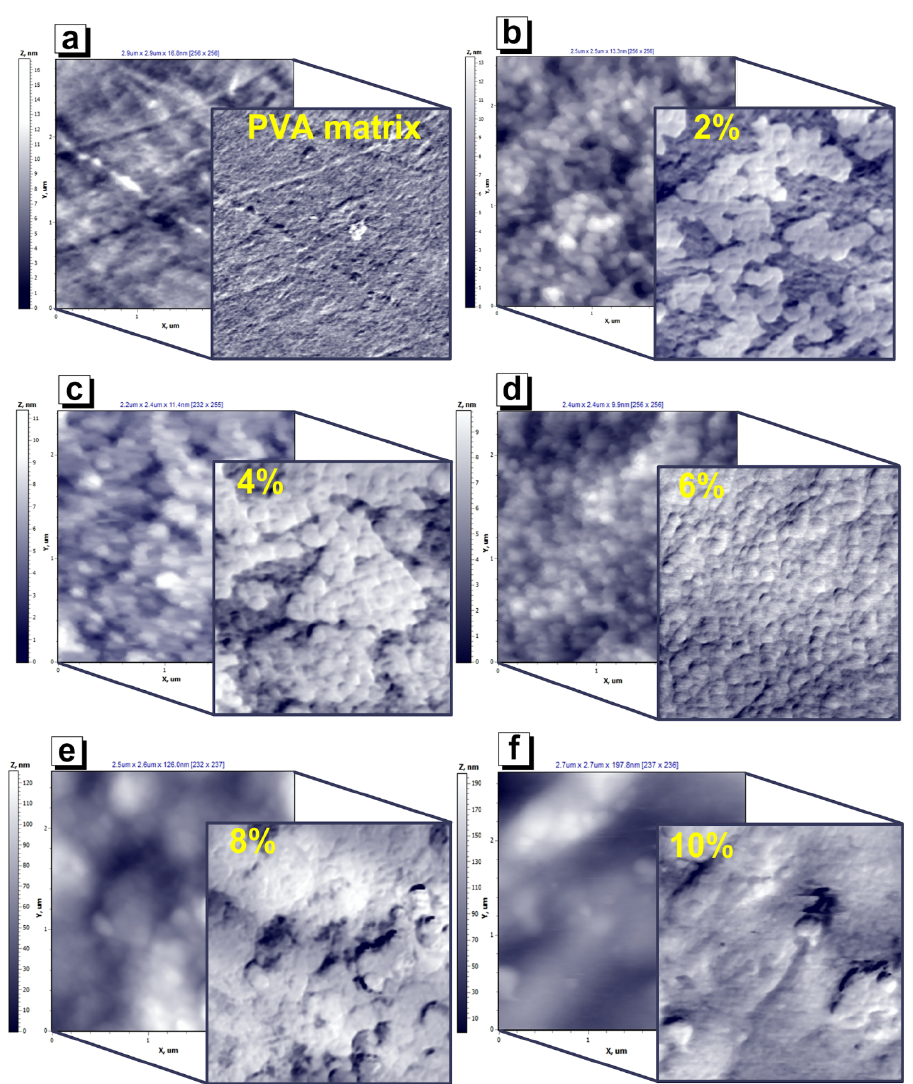
Figure 8. Surface microstructure including topography (bottom images) and lateral forces maps (overhead images) of ( a ) PVA matrix and “MZFA/PVA” nanocomposites with filler concentrations of ( b ) 2 wt.%; ( c ) 4 wt.%; ( d ) 6 wt.%; ( e ) 8 wt.%; ( f ) 10wt. %.